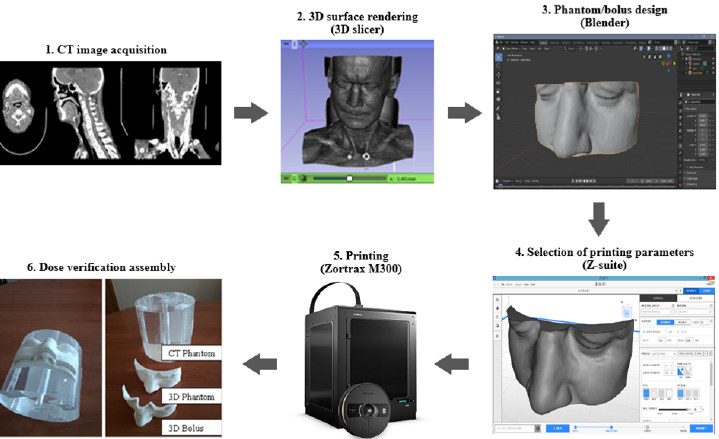
Figure 1. The workflow chart for creating and printing of patient-specific 3D devices for clinical use in radiotherapy.